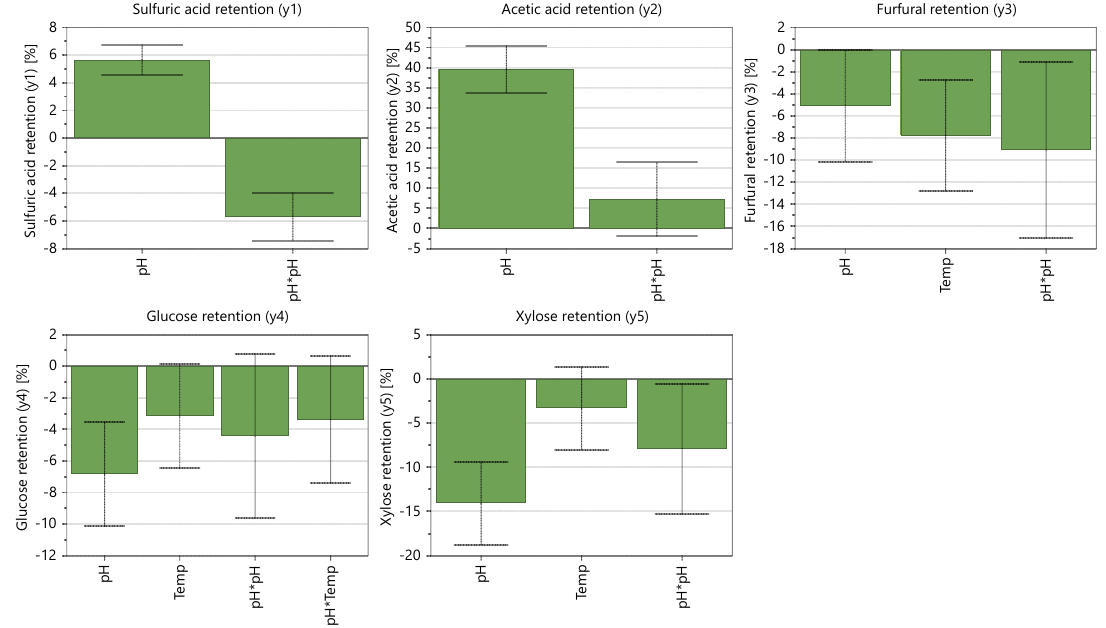
Figure 3. Coefficient plots for the identified models (scaled and centered).